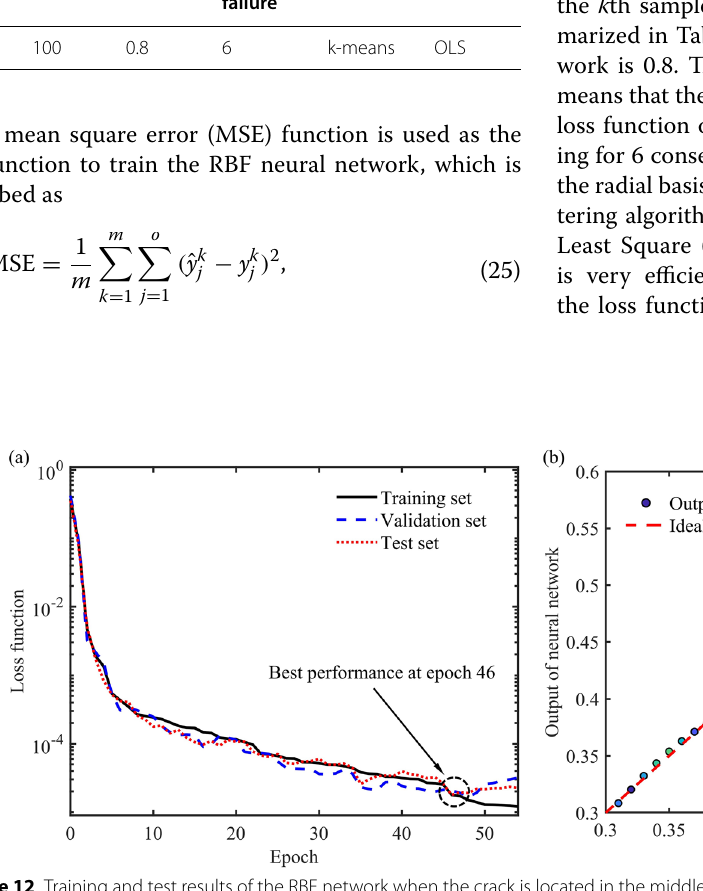
Table 4 Training parameters of the RBF network Loss Max function epochs